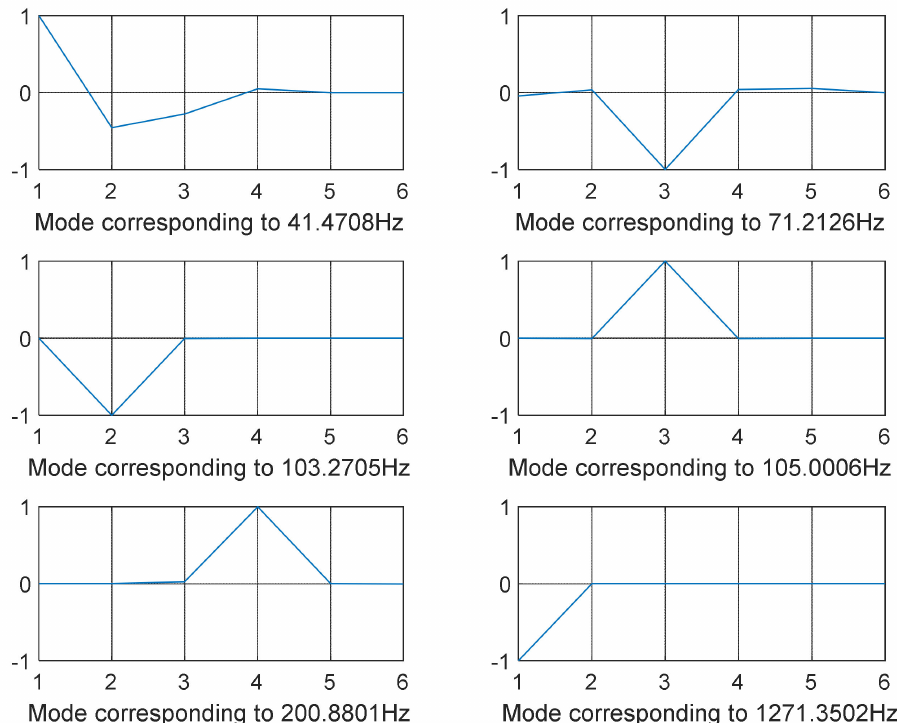
Figure 10. GWO-optimized mode shapes 7–12 (12-DOF model—combined loading).